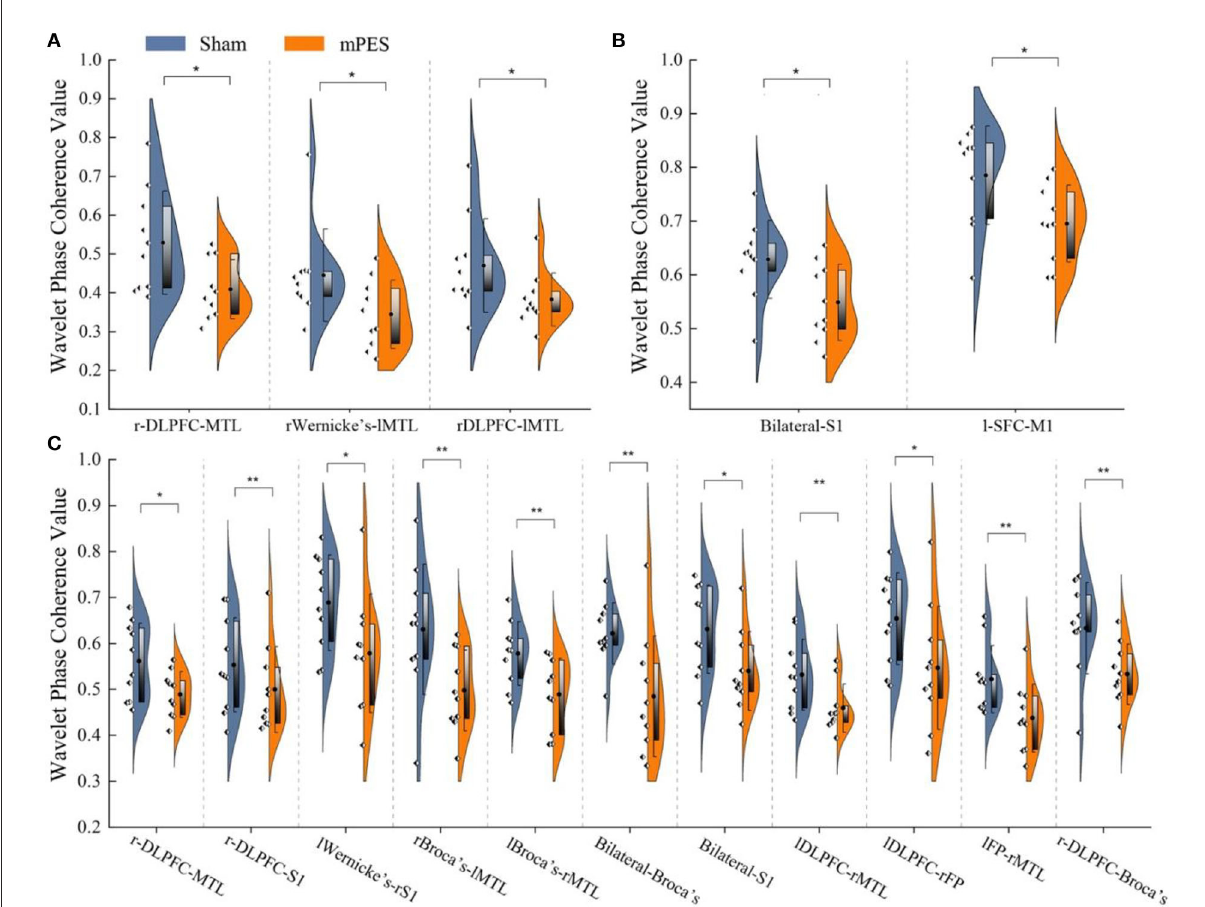
FIGURE3 The Comparison of WPCO value between Sham and mPES group in intervals III (A) , IV (B) , and V (C) . WPCO, wavelet phase coherence; mPES, modified pharyngeal electrical stimulation; r, right hemisphere; l, left hemisphere; FP, frontal pole; DLPFC, dorsolateral prefrontal cortex; M1, primary motor cortex; S1, primary somatosensory cortex; MTL, middle temporal lobe; Broca’s, Broca’s areas; Wernicke’s, Wernicke’s areas. * P < 0.05, ** P <